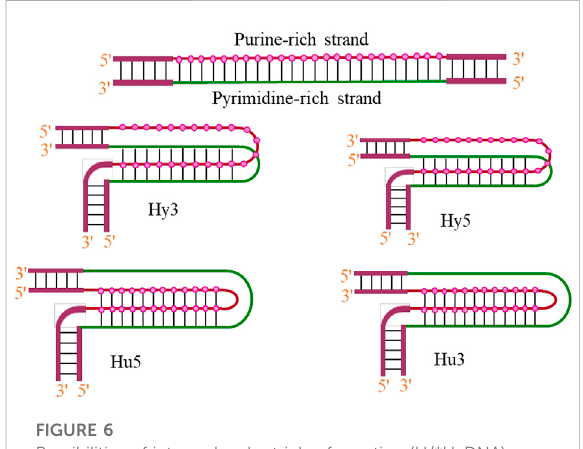
FIGURE 6 Possibilities of intramolecular triplex formation